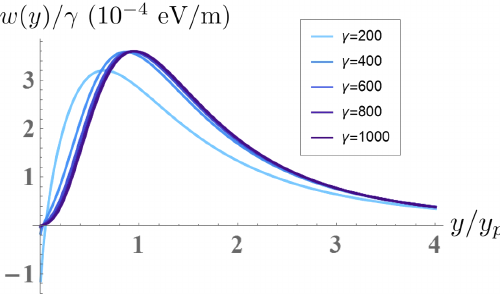
FIG. 2. w ð y Þ for various γ values with R ¼ 1 . 0 m and θ ¼ 0 . 04 rad. For large γ , w ð y Þ is maximized at y ≈ y Note that w is negative at small y due to the space charge field